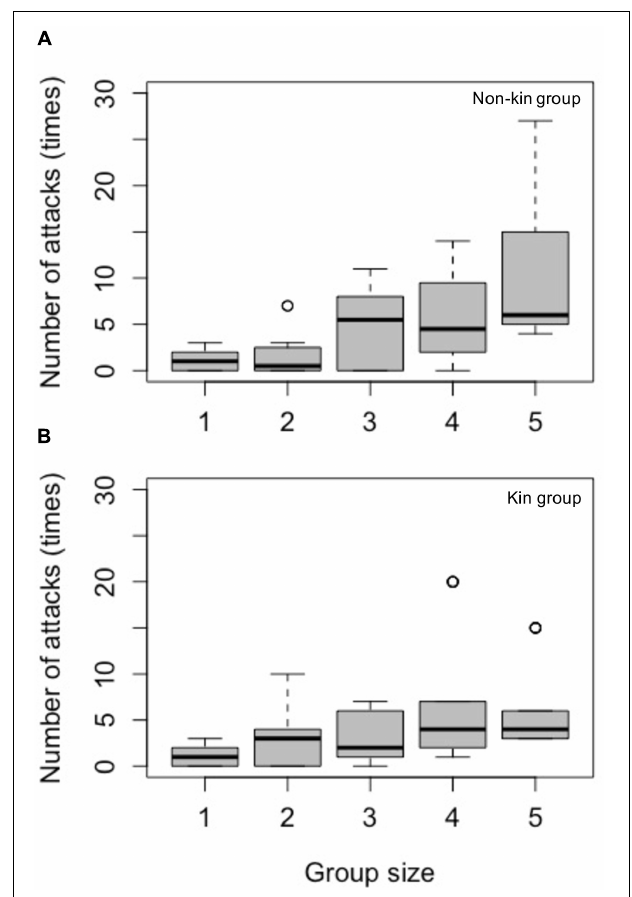
FIGURE 3 | Numbers of Nephila attacks (the sum of vibrations and captures) as a foraging cost of (A) non-kin and (B) kin groups in different group sizes. Two kinds of attacks are included in the analyses. The vibration, which is a tactic for Nephila to chase Argyrodes away, occurred more frequently. The number of this kind of attacks increased when group size > 2 in non-kin groups (see also Supplementary Table 4B ) and when group size > 3 in kin groups ( Supplementary Table 4D ). The number of captures, a tactic to kill the Argyrodes , occurred in very low frequency and showed no difference across group sizes (see also Supplementary Table 5 ). Group size one: n = 14; group size two: n = 8 for non-kin group and n = 13 for kin group; group size three: n = 6 for non-kin group and n = 6 for kin group; group size four: n = 4 for non-kin group and n = 6 for kin group; group size five: n = 5 for non-kin group and n = 5 for kin